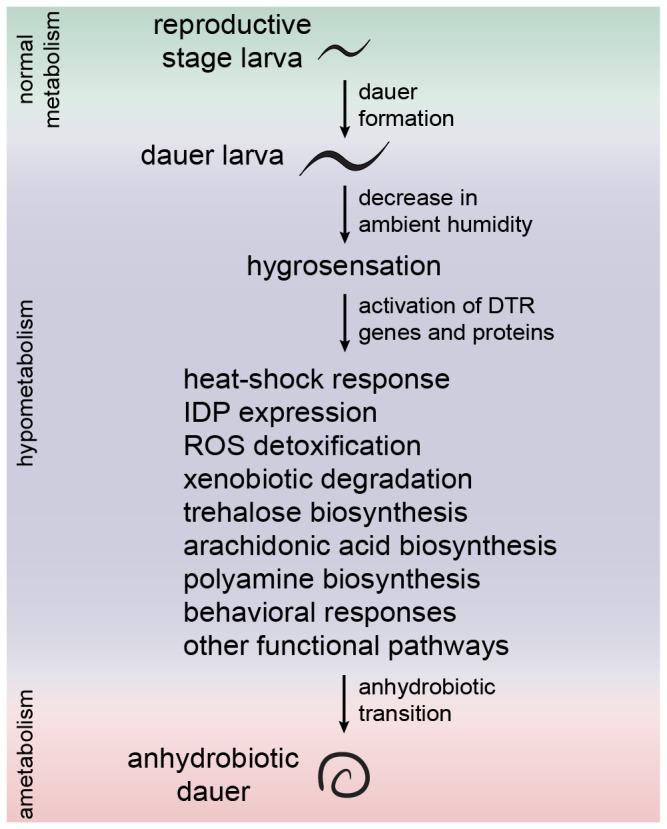
Suggested model of the main strategies of desiccation tolerance in C.
elegans. The hypometabolic dauer larva senses a decrease in ambient humidity, perhaps via head neurons, and initiates a desiccation response at different levels. As a result of this, ROS and xenobiotics are eliminated, proteins and membranes are stabilized, and other essential functions are fulfilled. The ametabolic transition (anhydrobiosis) can only succeed under these conditions.